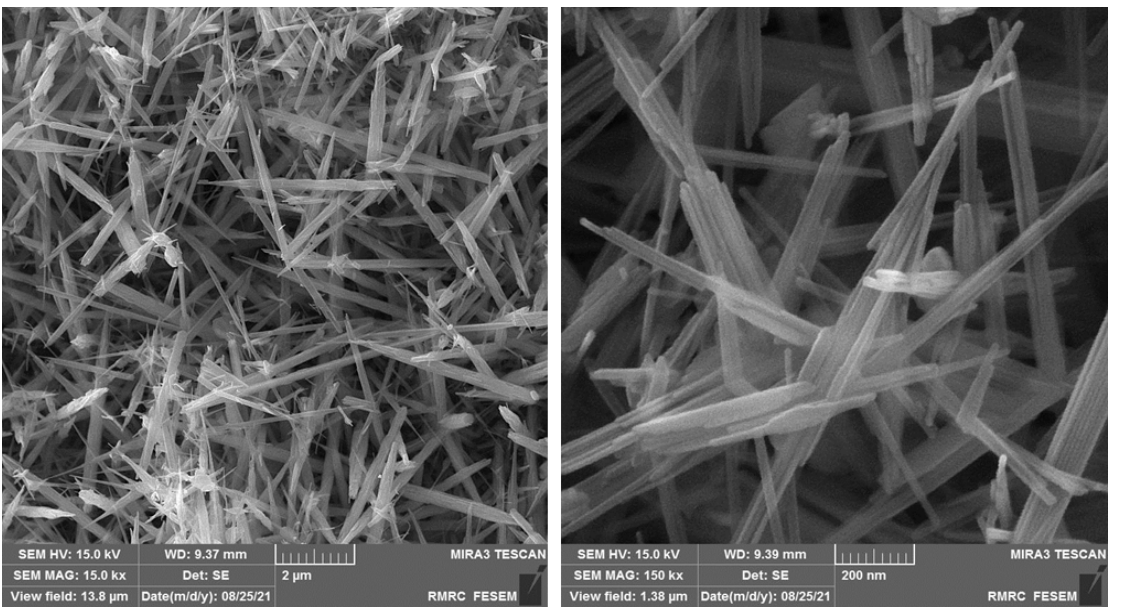
Figure 1. FE-SEM images captured for as-fabricated manganese dioxide nanorods, with various magnifications.